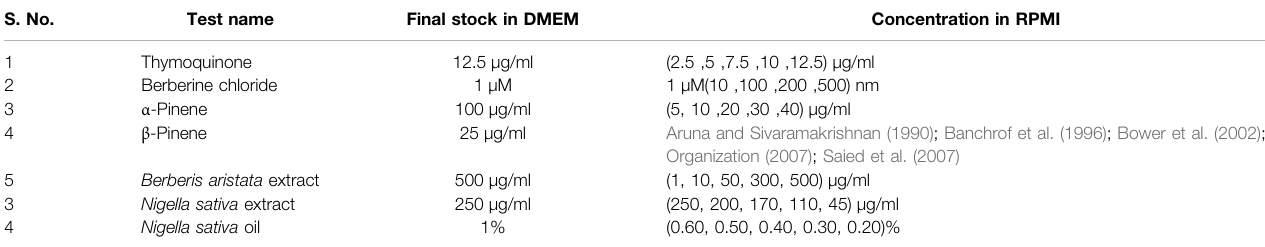
TABLE 3 | Final stock concentration in the study for MTT Assay. S. No.